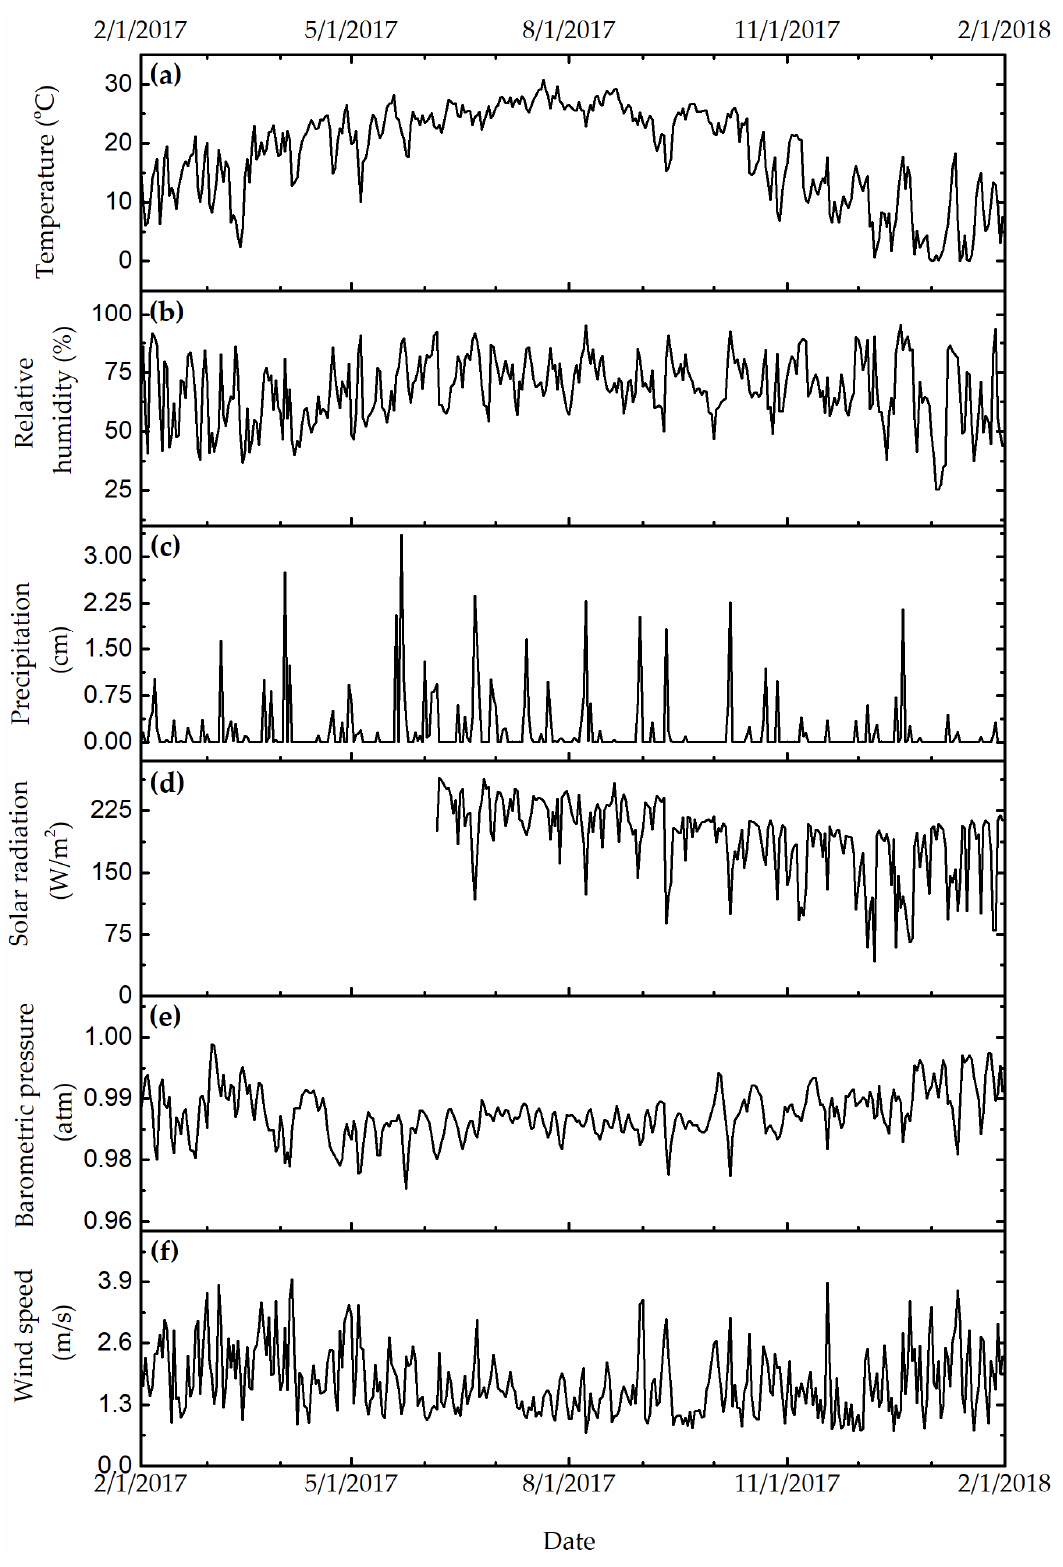
Figure 3. ( a , ◦ C) Daily temperature, ( b , %) relative humidity, ( c , cm of H 2 O) precipitation, ( d , W/m 2 ) solar radiation, ( e , in mbar) barometric pressure, and ( f , m/s) resultant wind